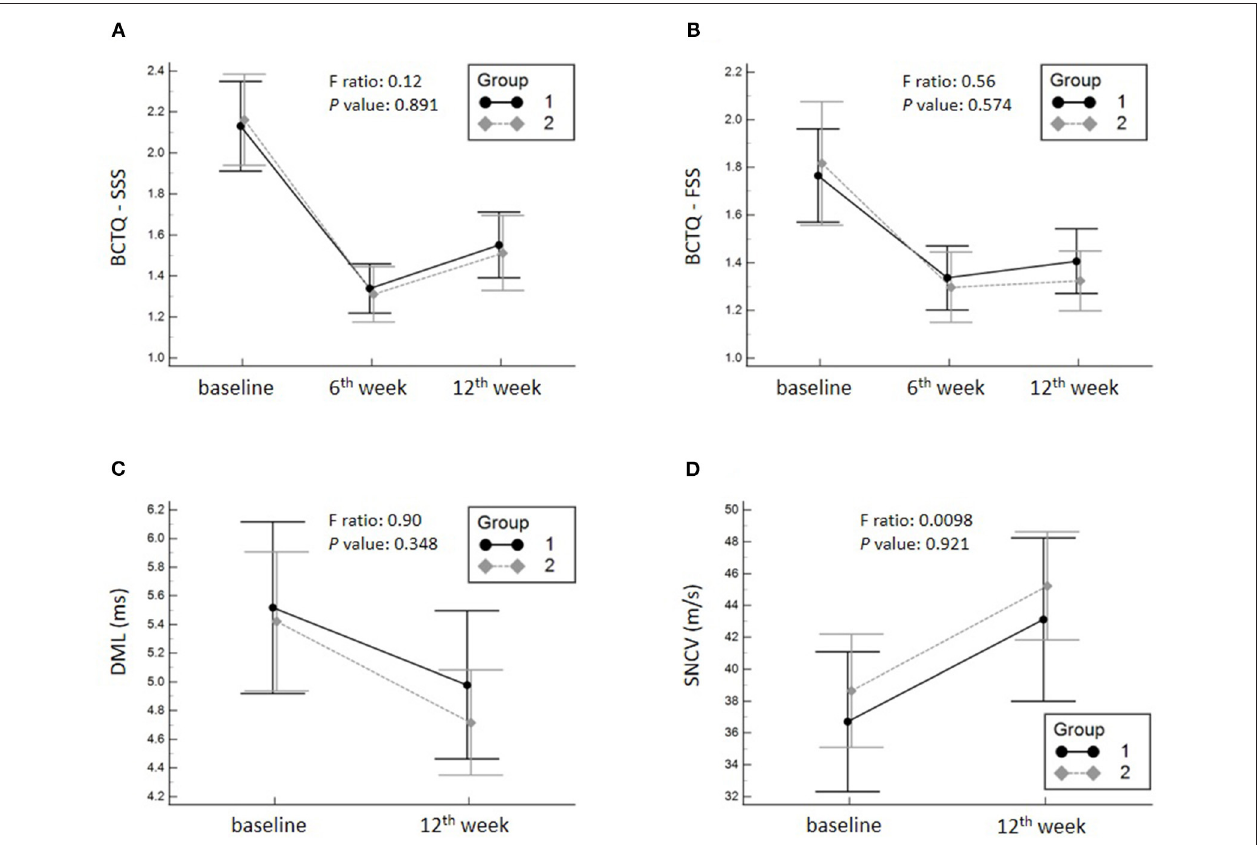
FIGURE 3 | Mean changes and the corresponding 95% confidence intervals pertaining to the symptom severity scale (SSS) (A) of the Boston Carpal Tunnel Questionnaire (BCTQ), functional status scale (FSS) (B) of the BCTQ and distal motor latency (DML) (C) and sensory nerve conduction velocity (SNCV) of the median nerve (D) . Group 1, hydrodissection with corticosteroid; Group 2, corticosteroid perineural injection